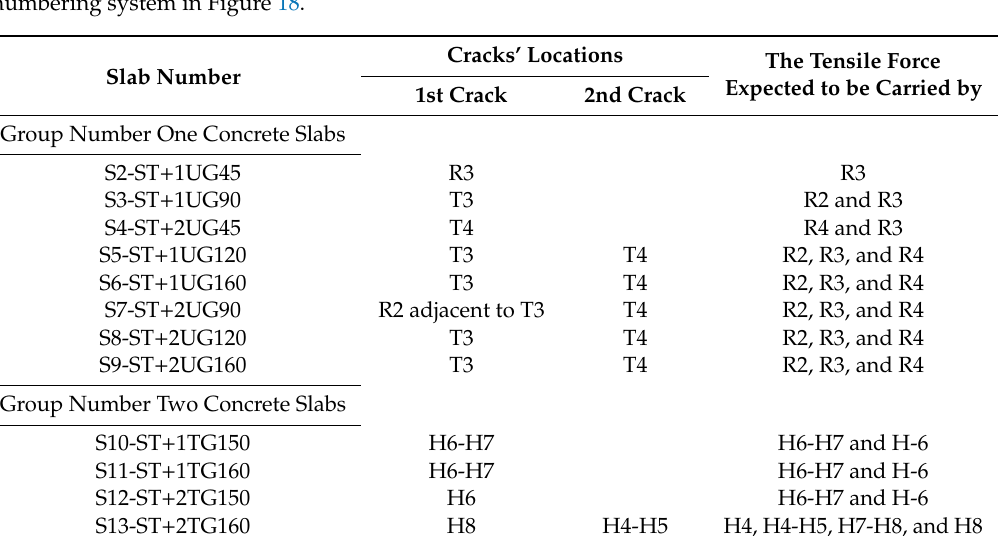
Figure 19. Probability distribution analysis of geogrids strain values at the steel-yield strain. Table 5. Locations of cracks per each hybrid reinforced concrete slab, according to the mentioned numbering system in Figure